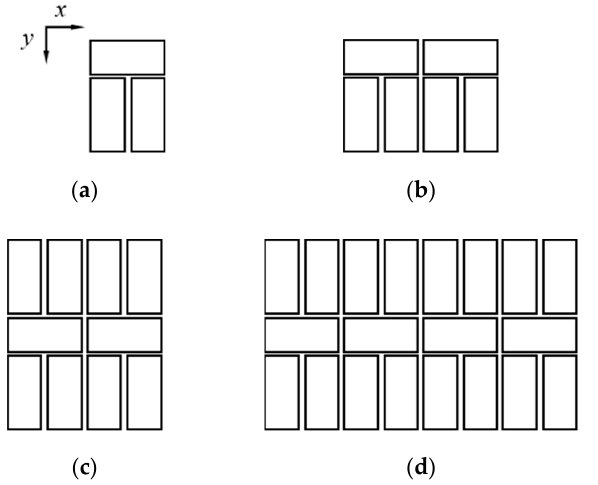
Figure 7. Schemes of horizontal assembly formed by ( a ) 3, ( b ) 6, ( c ) 10 and ( d ) 20 modules.